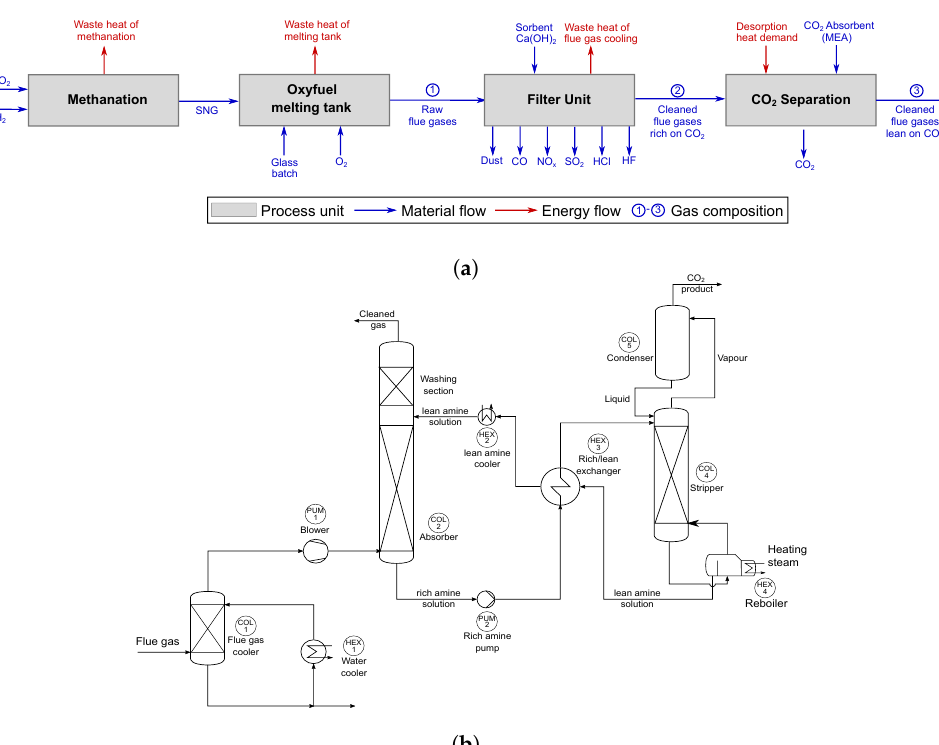
Figure 2. (a) Flowsheet for the conceptual integration of a CO 2 separation processes in glass melting systems. ( b ) Principal flow sheet of the components of a CO 2 absorption plant with an amine-based